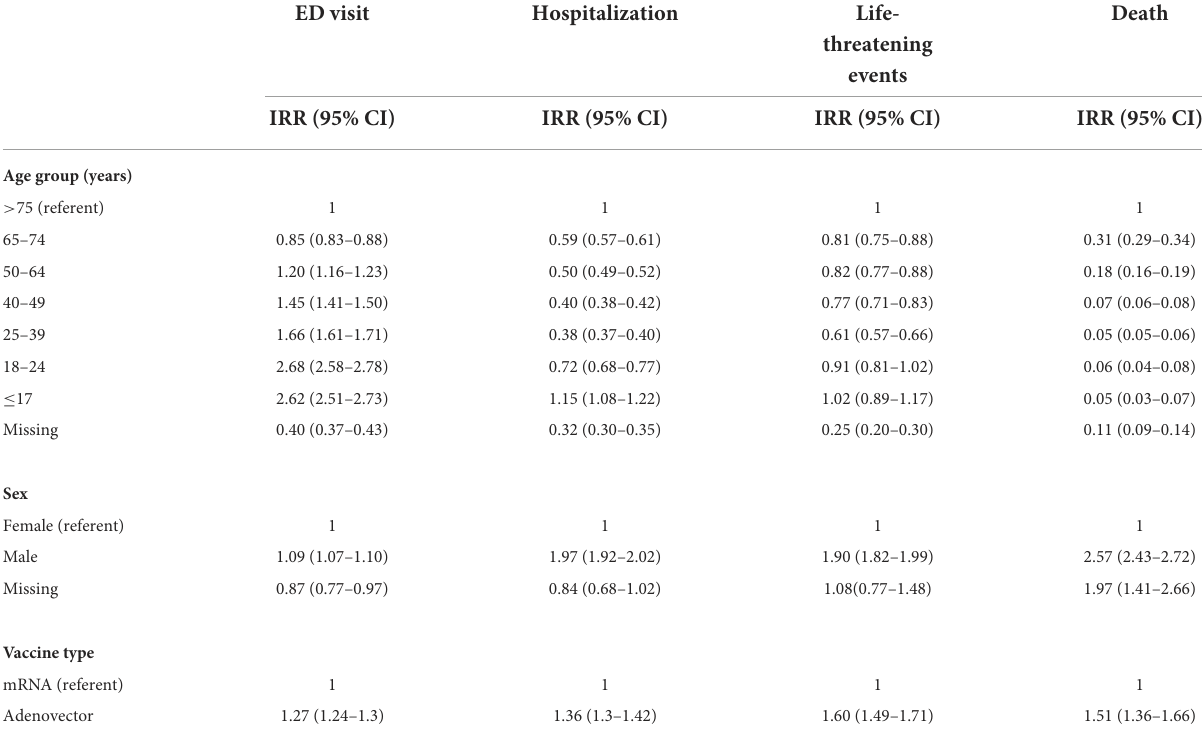
TABLE 3 Incidence rate ratios for reported